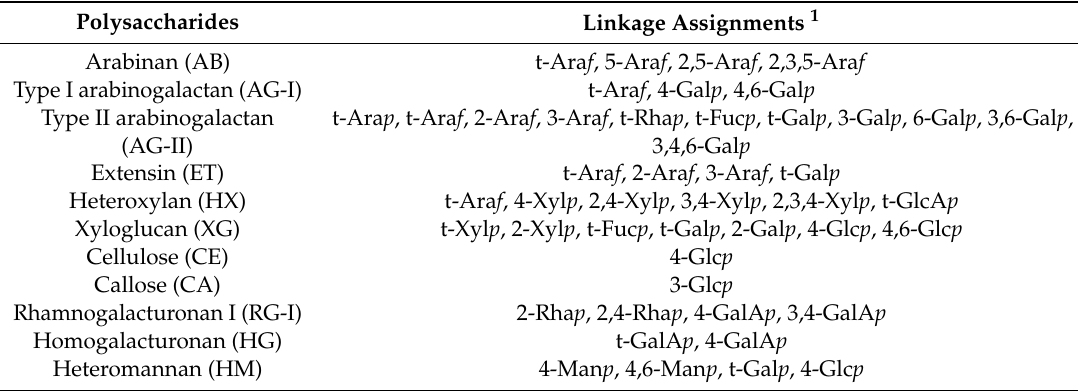
Table 1. Polysaccharide linkage